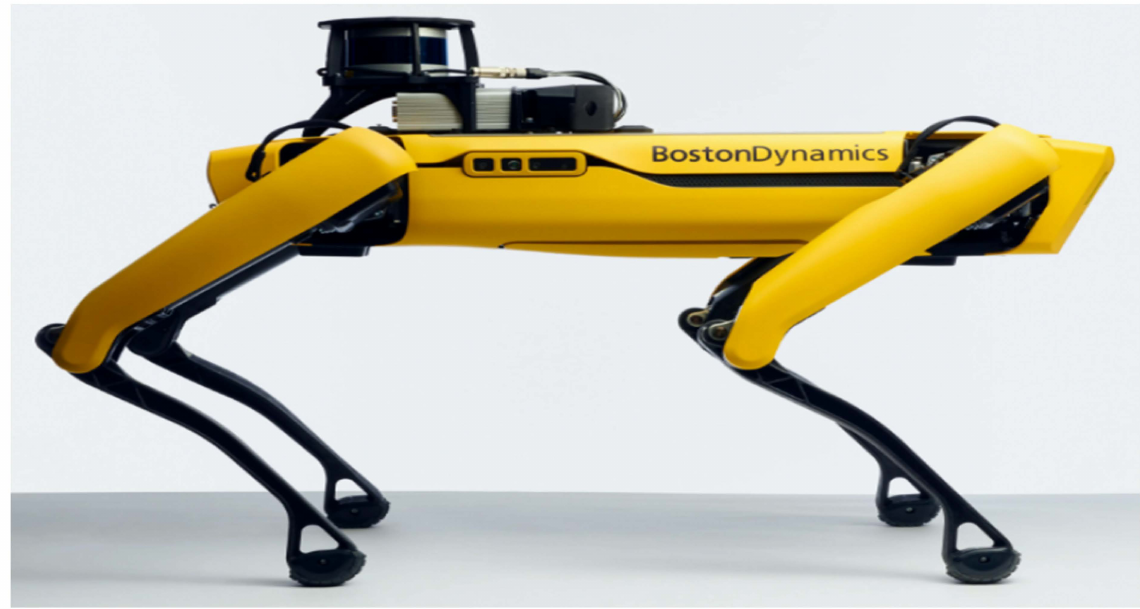
Figure 8. Spot dog mobile robot developed by Boston Dynamics